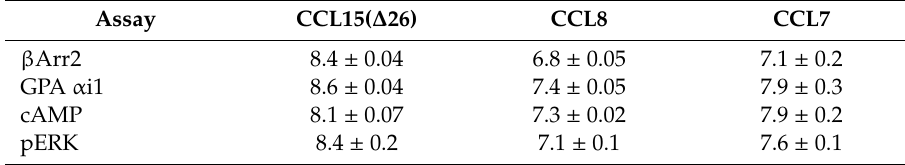
Table A1. Transduction coe ffi cients Log( τ / K A ) for wild type chemokines 1 .